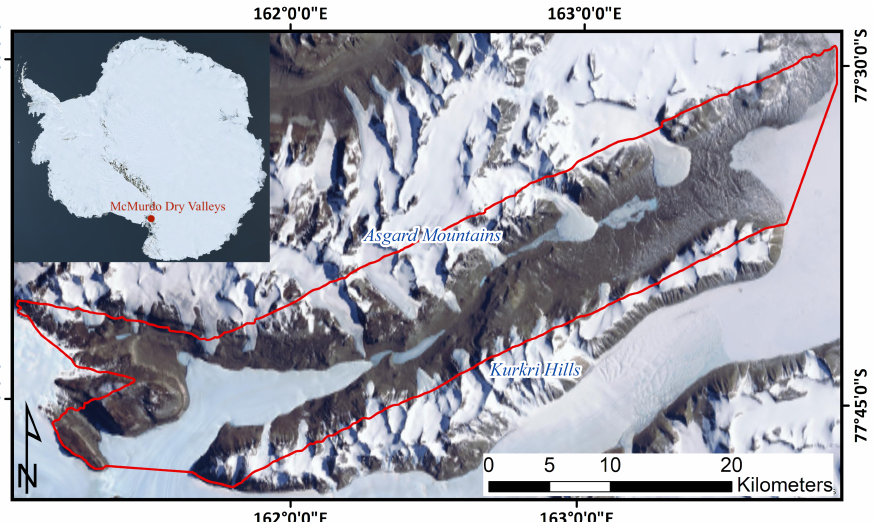
Figure 3. Location map of Taylor Valley, Antarctica with the area of interest highlighted in red. Imagery courtesy of Earthstar